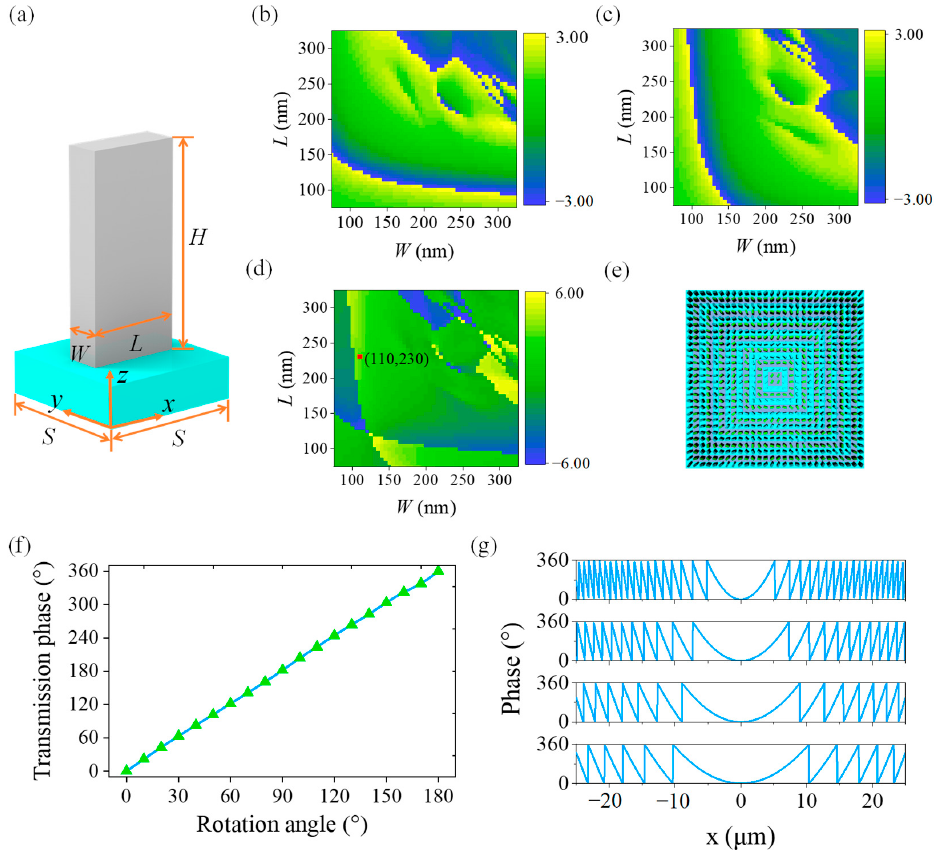
Figure 2. A multifocal metalens. ( a ) The 3D model of a unit cell, where W , L , H and S represent width, length, height and period size of a unit cell, respectively. Transmission phase of the polarization direction of the incident light along the ( b ) x axis and ( c ) y axis. ( d ) Phase difference of the polarization direction of the incident light along the x and y axis. ( e ) Nested square rings (different colors) of a metalens used to generate different phase distributions for different focal lengths. ( f ) Relationship between rotation angles of nanofins and the transmission phase. ( g ) Phase distributions of the bionic metalenses with different focal lengths (from top to bottom: f = 25 µ m, 50 µ m, 75 µ m, and 100 µ m,